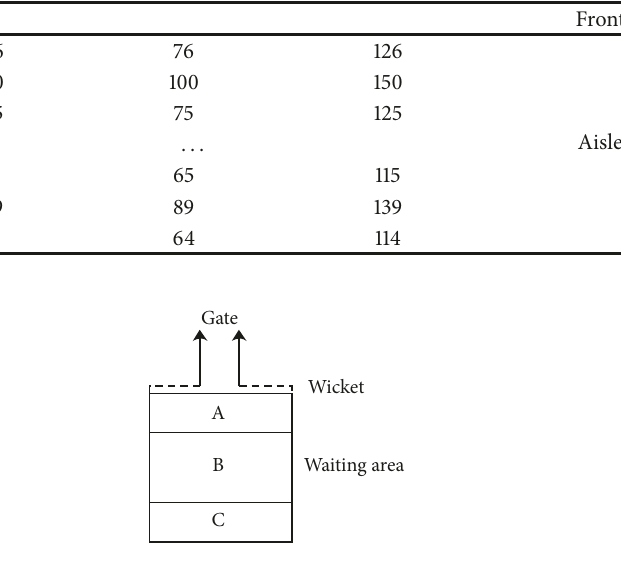
Figure 2: The three areas in front of the wicket.